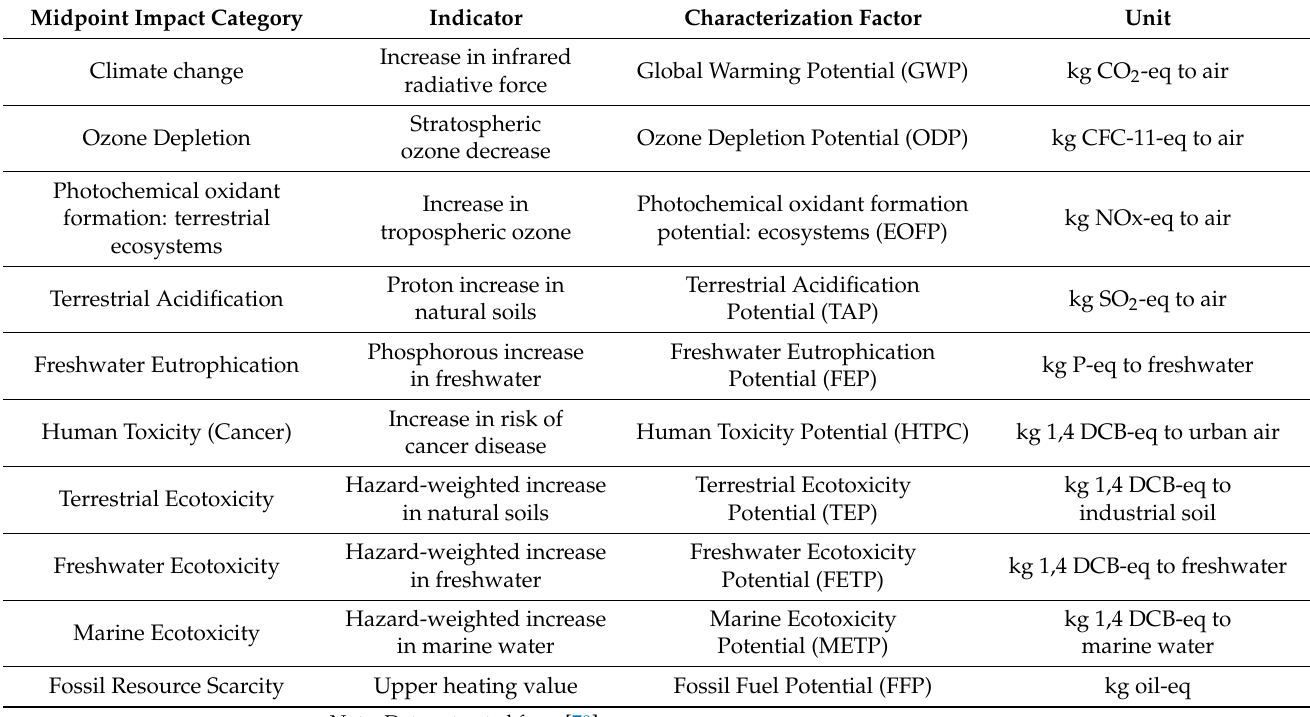
Table 4. Recipe midpoint impact